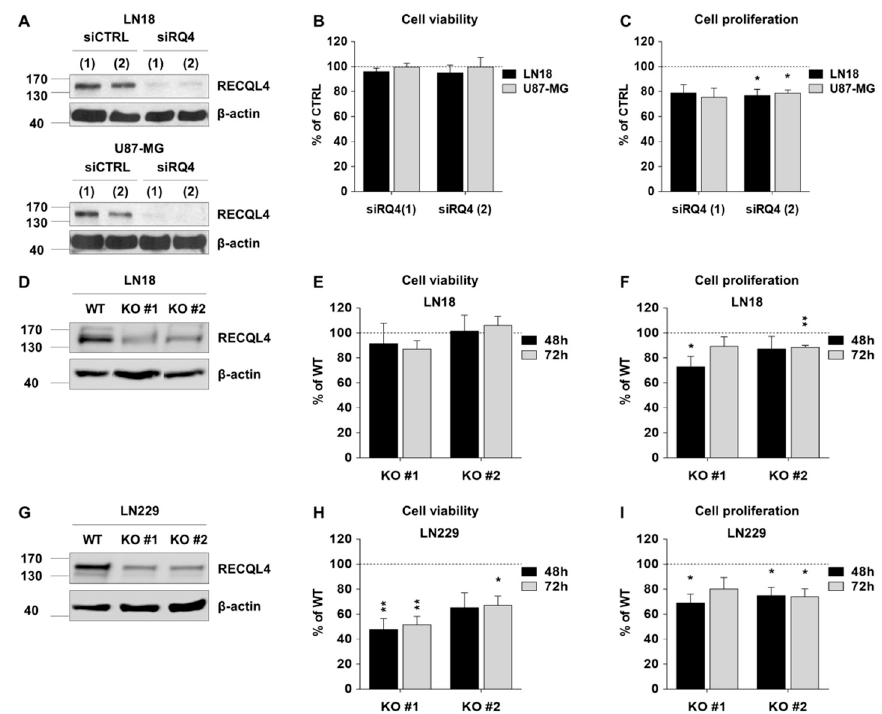
Figure 2. RECQL4 depletion a ff ects cell viability and proliferation of certain glioblastoma cells. ( A ) Representative immunoblots showing e ff ective knockdown of RECQL4 (48 h post-transfection) with two di ff erent siRNAs (siRQ) in LN18 (upper panel) and U87-MG (bottom panel) cells. β -Actin was